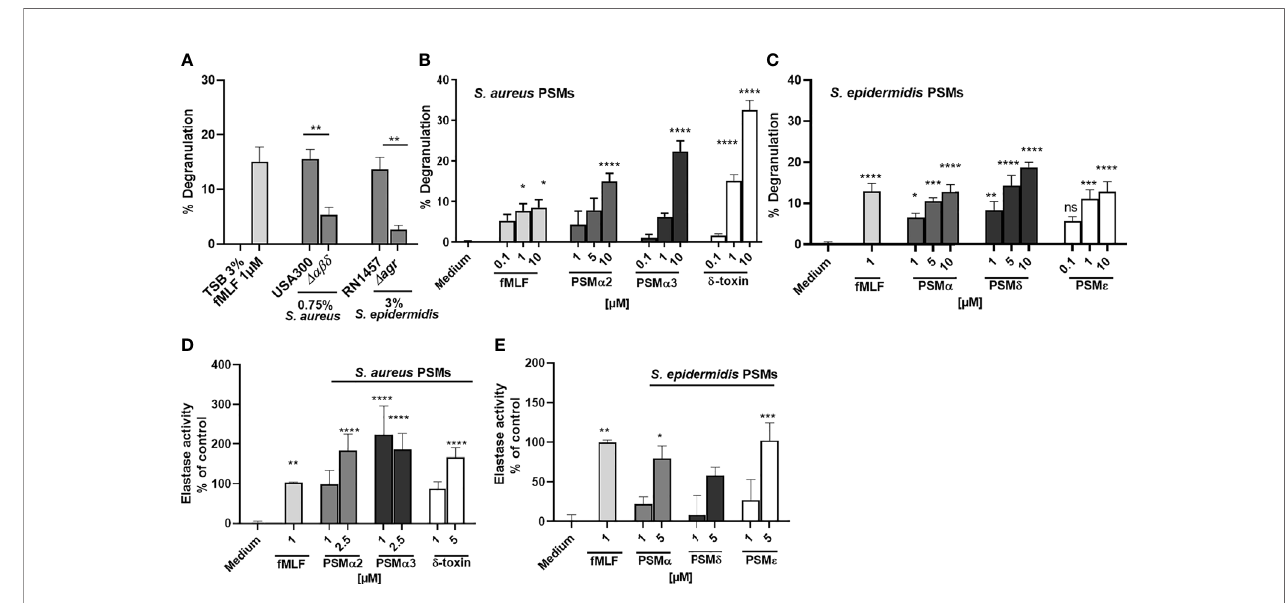
FIGURE 1 | PSMs in culture fi ltrates of S. aureus and S. epidermidis induce neutrophil degranulation and NE release. Neutrophils (polymorphonuclear leukocytes=PMNs) were stimulated with (A) culture fi ltrates of S. aureus (0,75%), S. epidermidis (3%) or the indicated isogenic PSM or agr mutant (B) with fMLF, PSM a 2, PSM a 3 or d -toxin or (C) with S. epidermidis PSM a , PSM d or PSM e , and degranulation ( b -glucuronidase release) was analyzed. (D) Neutrophils were stimulated with the indicated S. aureus or (E) S. epidermidis PSMs and elastase activity was analyzed. Data represents mean and SEM of at least three independent experiments. ns, not signi fi cant, *P < 0.05; **P < 0.01; ***P < 0.001; ****P < 0.0001 signi fi cant difference versus the indicated wild-type strains as calculated by paired two-tailed Student ’ s t tests (A) or one-way ANOVA with Dunnett ’ s multiple comparisons test (B – E)